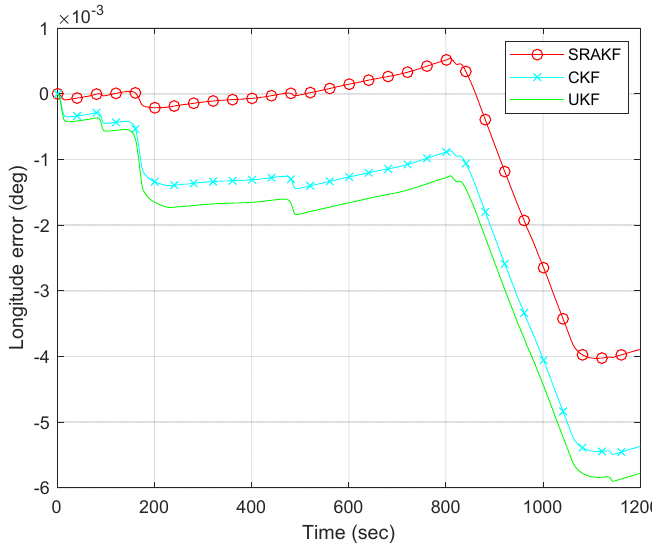
Figure 9. Latitude errors for the surface lake trial.